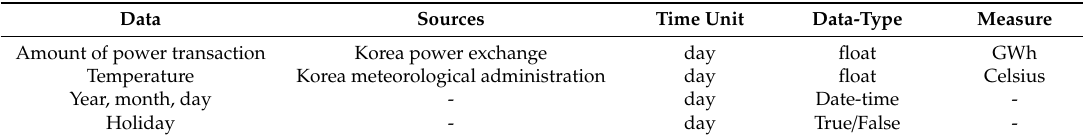
Table 5. Characteristics of acquired